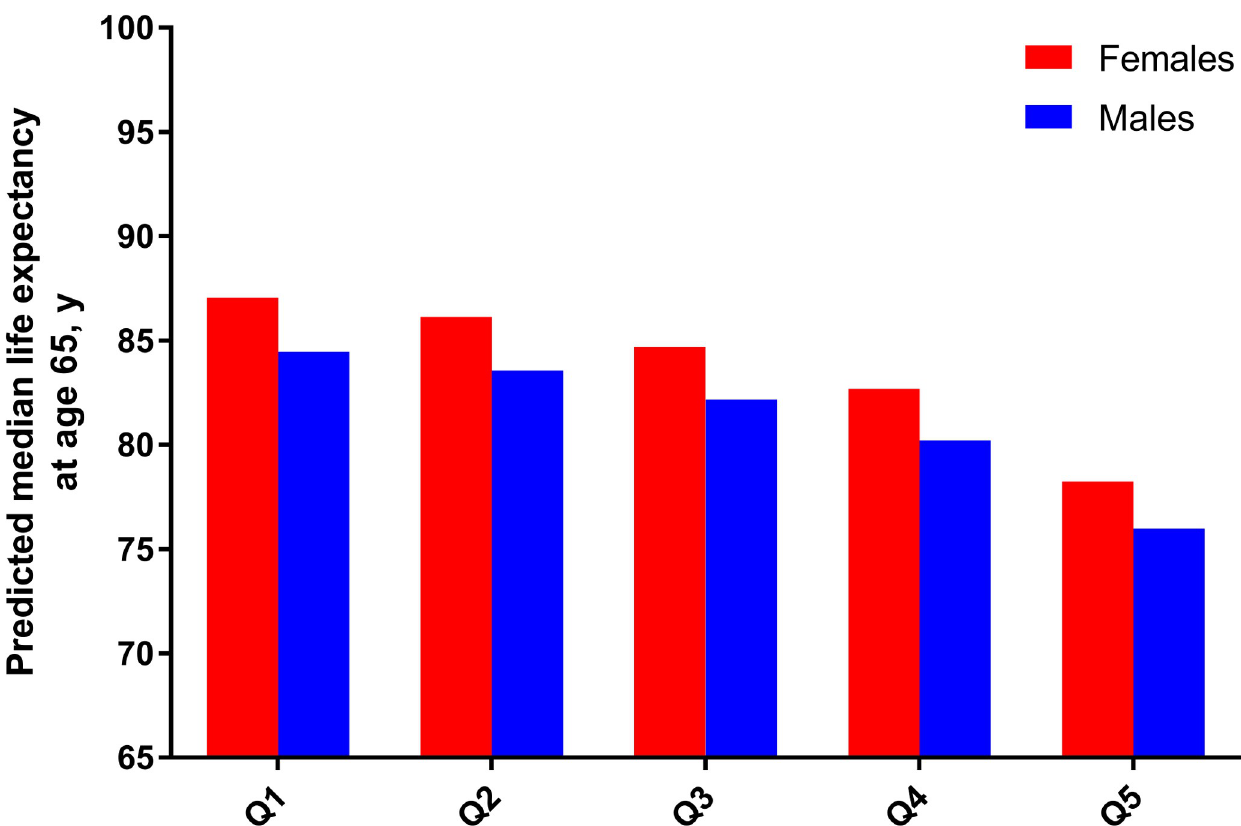
Fig 6. Predicted median life expectancy at age 65 years by sex and the 5 quintiles for PhenoAgeAccel. Q1–Q5 indicate the 5 quintiles of PhenoAgeAccel. Results are based on parametric survival models (Gompertz distribution) that include quintiles of PhenoAgeAccel, chronological age, and sex. Estimates represent the predicted age by which 50% of the population is expected to have died for each sex by quintile group, assuming a baseline age of 65 years.